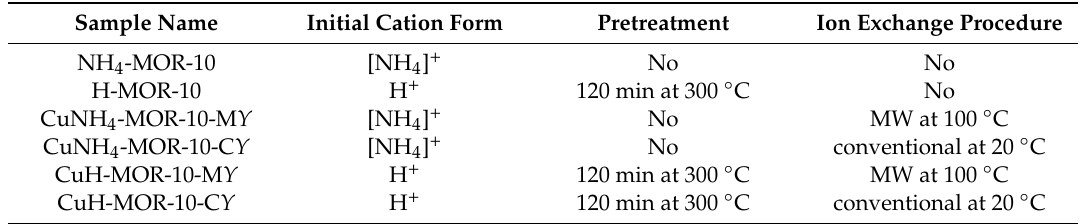
Table 4. Classification of the studied copper-exchanged samples according to the undergone exposure. Processing time is indicated for one stage of the exchange. Every time the exchange was repeated, the exposure time